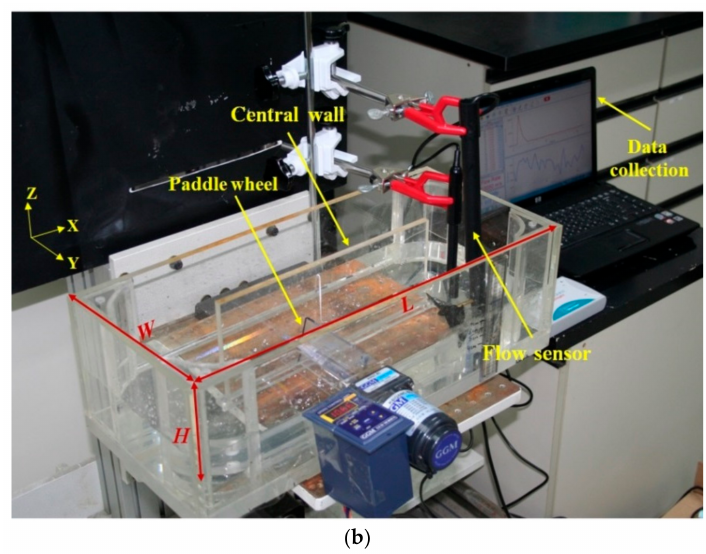
Figure 1. ( a ) Computational models of the open raceway pond and microalgal cells used in the simulations and ( b ) experimental setup with a laboratory-scale raceway